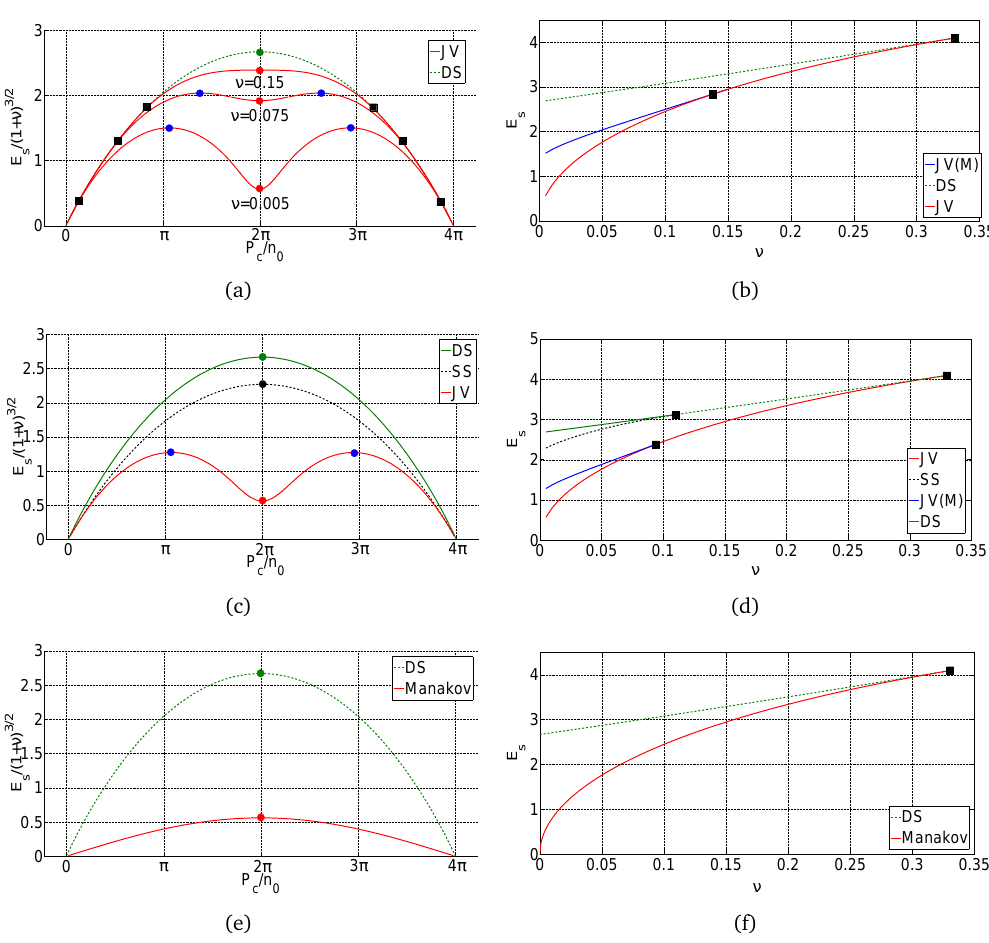
Figure 5: Families of solitary-wave solutions. Left column: dispersion relations with excita- tion energy E vs. canonical momentum P for ν = 0.005 [ or as indicated in panel (a) ] . Right s c ≡ dE / dP = 0, column: E vs. the coupling parameter ν for stationary solitary waves ( v s s s c = 0). The high- marked by dots in the left column). (a), (b): γ = 1 (no cross-interaction, g c est energy branch corresponds to dark soliton solutions (green, labeled ‘DS’); the Josephson vortex (red, labeled ‘JV’) corresponds to the lowest available energy state for given P . Dif- c ferent values of ν are shown in panel (a). For ν < 0.1413 three local extrema coexist, each corresponding to a stationary solitary wave solution. There are two degenerate maxima (blue, labeled ‘JV(M)’), and one minimum corresponding to the stationary Josephson vortex solu- tion. (c), (d): γ = 0.5. Staggered soliton solutions (unstable) appear at intermediate energies for 0 < γ < 1 (black, labeled ‘SS’). (e), (f): γ = 0. Josephson vortices and staggered soli- tons merge into the highly degenerate branch of “Manakov” solutions (stable). Throughout: full (dashed) lines indicate stable (dynamically unstable) solutions; square markers indicate bifurcation